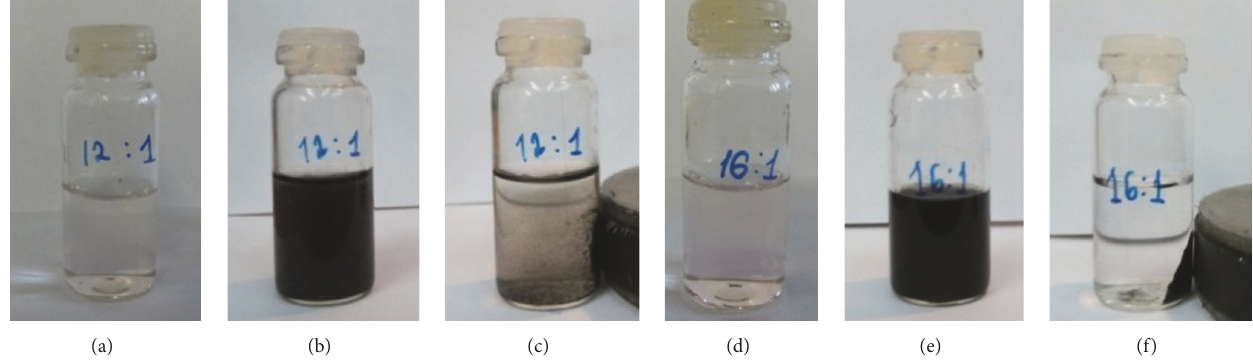
Figure 5: Color transformation of Co 2+ -BH20 solution before (a, d) and after (b, e) reduction; the collection of CoNPs by a magnet (c, f).